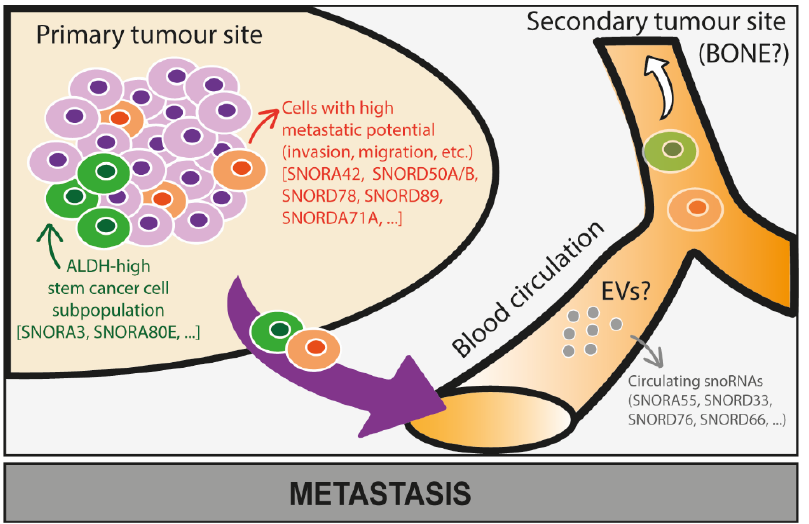
Figure 5. Potential roles of snoRNAs in the metastatic progression of cancer cells. The role of snoRNAs in the metastatic progression of cancer cells in bone is still largely unknown and needs further investigation. Based on some studies conducted on snoRNA expression levels in cancer cells at the primary tumour site, we here speculate that some snoRNAs proven to be associated with stem-like properties (e.g . , SNORA3, SNORA80E) and increased metastatic properties—invasion and migration—(e.g . , SNORA42, SNORD50A/B, SNORD78, SNORD89, SNORDA71A) of cancer cells might also promote bone metastasis. Moreover, expression levels of snoRNAs (e.g . , SNORA55, SNORD33, SNORD76, SNORD66) are dysregulated in circulating cancer cells that might successfully colonise bone, which requires further investigation.